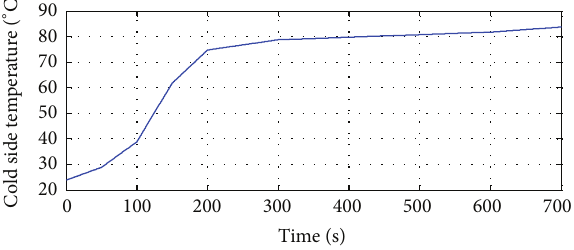
Figure 7: Temperature variation in the cold side of